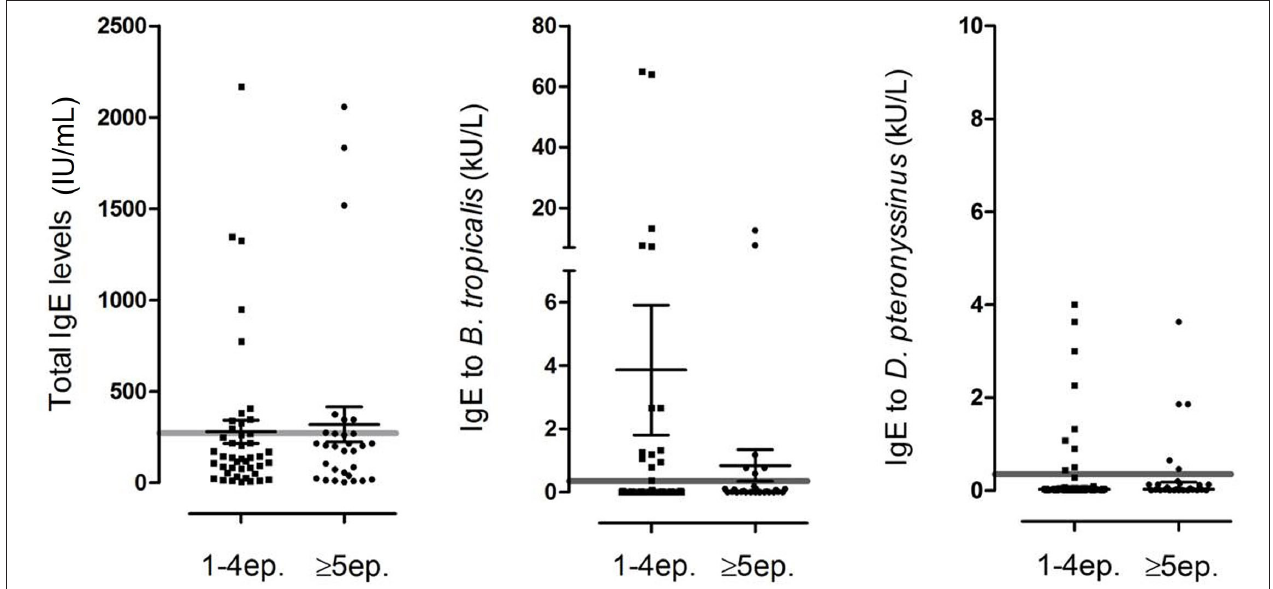
FIGURE 3 | Distribution of total and specific IgE levels in 74 children in which blood tests were available 2 weeks after discharge according to the number of ER visits due to wheezing. Each dot represents an individual, error bars indicate geometric mean and 95% confidence interval. Gray line indicates 300 IU/mL for total IgE and 0.35 kU/L for specific IgE.